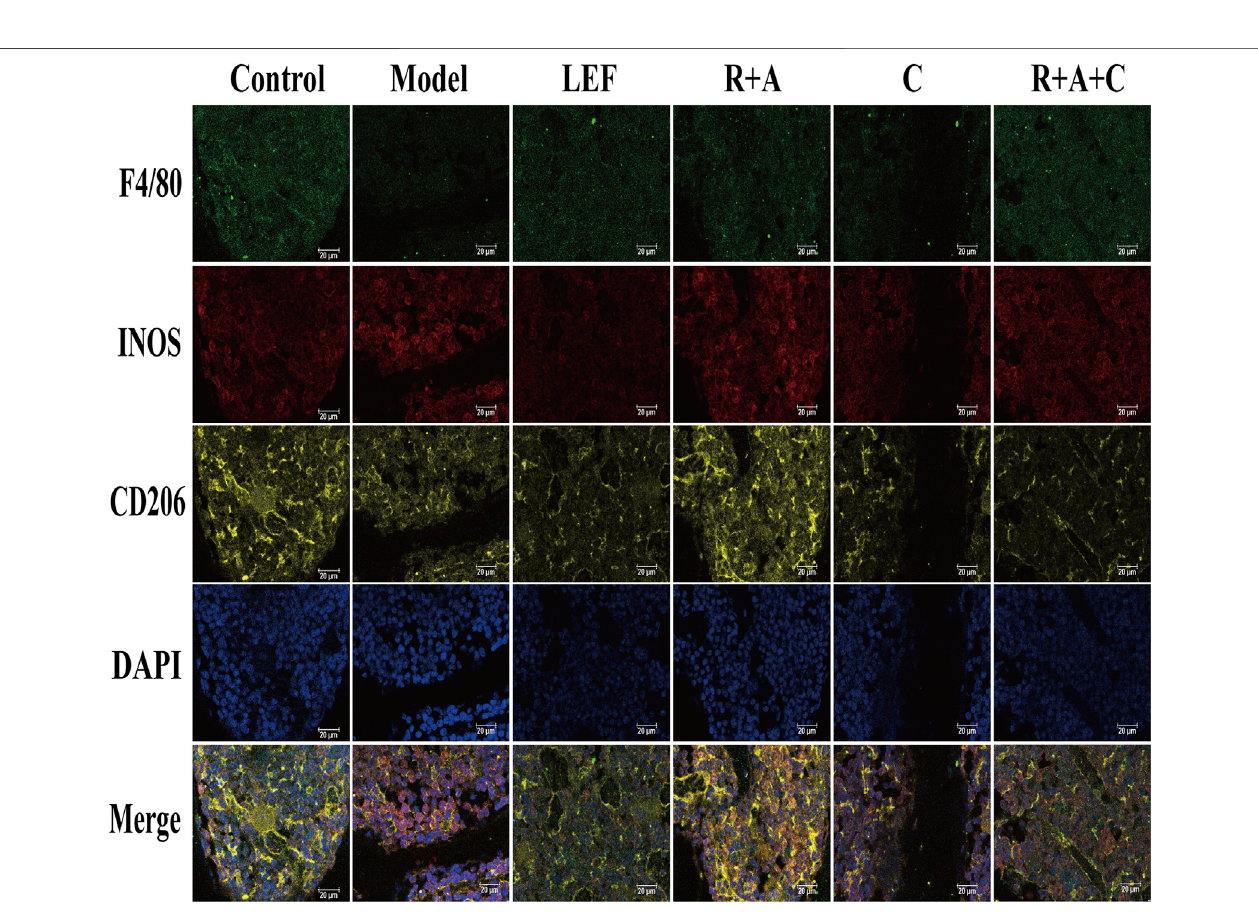
FIGURE 7 | Representative immuno fl uorescence images of macrophage distribution. Three types of fl uorescence labeled M1 and M2 macrophages: F4/ 80 + INOS + CD206 − cells are M1 macrophages, F4/80 + INOS − CD206 + cells are M2 macrophages, and F4/80 + NOS2 + CD206 + cells are M1 and M2 mixed macrophages. The scale bar corresponds to 20 µm